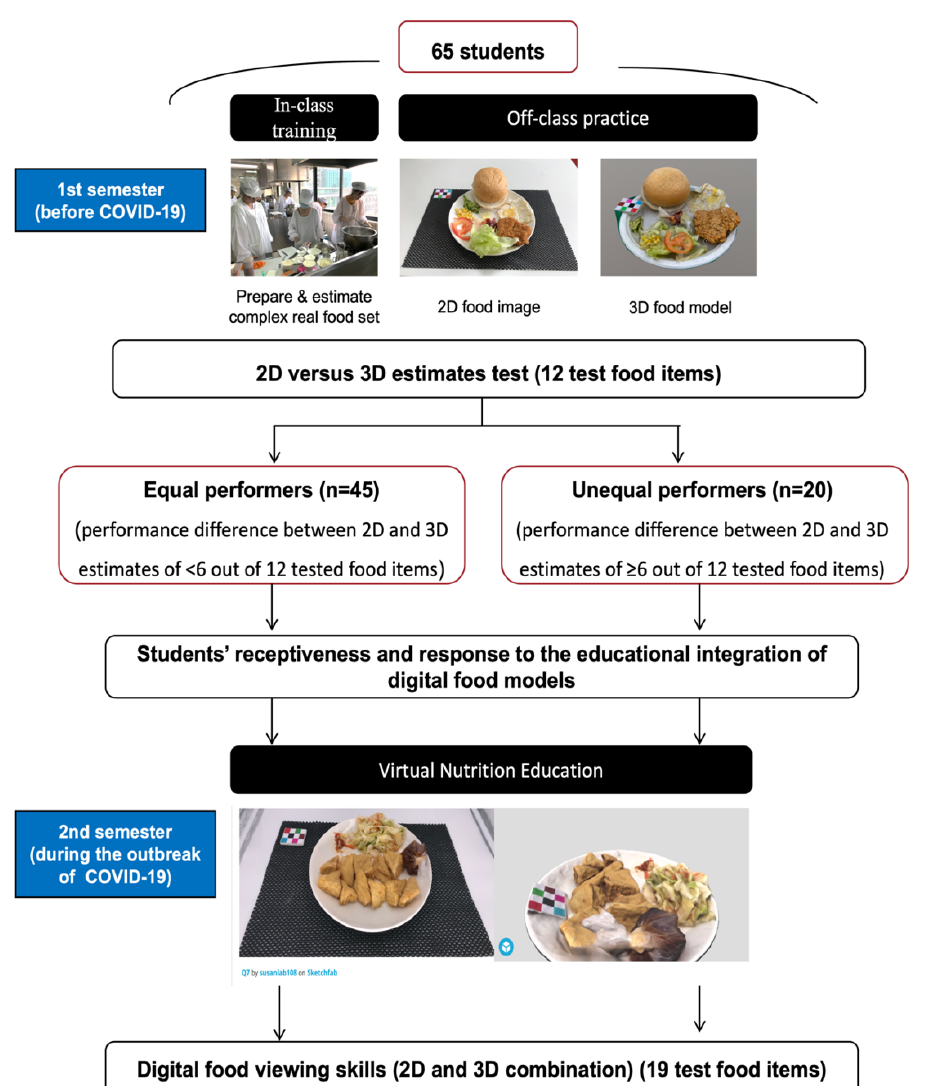
Figure 1. Study flowchart of educational integration of digital food models into a nutritional practicum course.